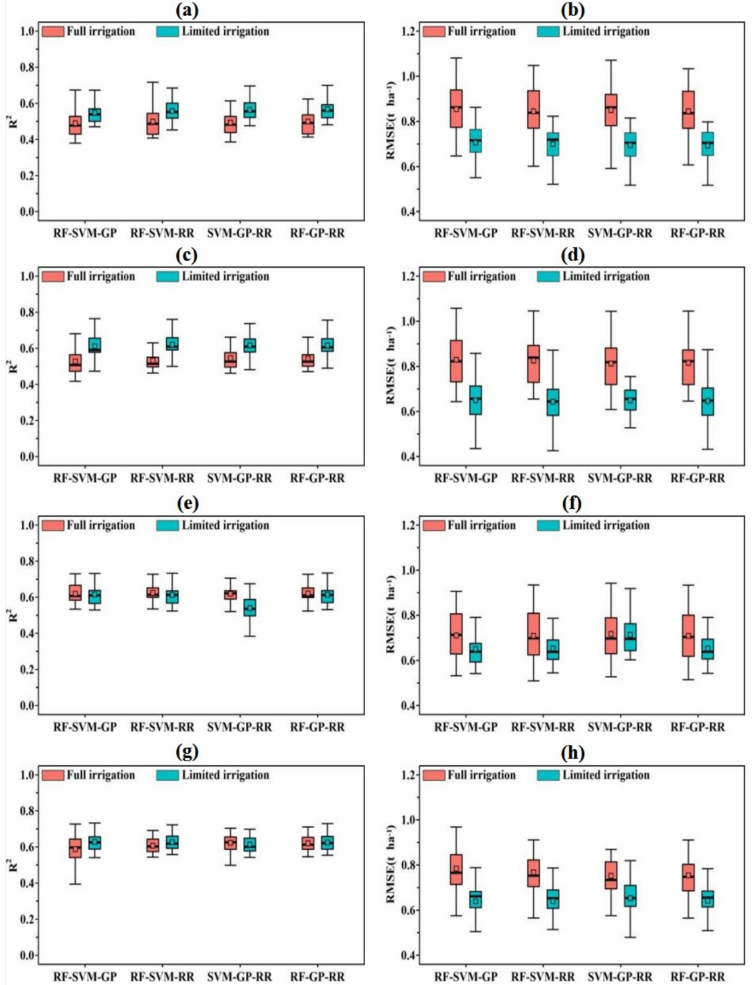
Figure 8. The statistical distributions of prediction accuracy of the stacking regression when including three base learners for grain yield prediction in the test phases; ( a ) distributions of R 2 at the heading stage; ( b ) distributions of RMSE at the heading stage; ( c ) distributions of R 2 at the flowering stage; ( d ) distributions of RMSE at the flowering stage; ( e ) distributions of R 2 at the early grain filling stage; ( f ) distributions of RMSE at the early grain filling stage; ( g ) distributions of R 2 at the mid-grain filling stage; ( h ) distributions of RMSE at the mid-grain filling stage. Abbreviations: RF, random forest; SVM; support vector machine; GP, Gaussian process; and RR, ridge